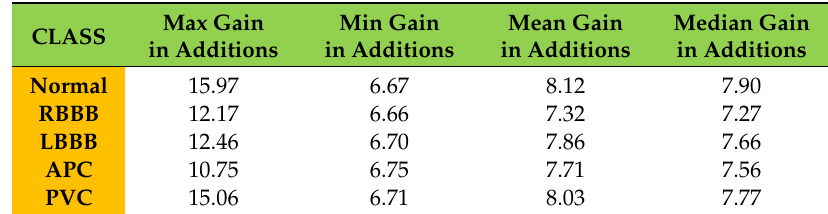
Table 3. Summary of the adaptive-rate finite impulse response (ARFIR) computational gains, in additions, over the classical FIR filtering.